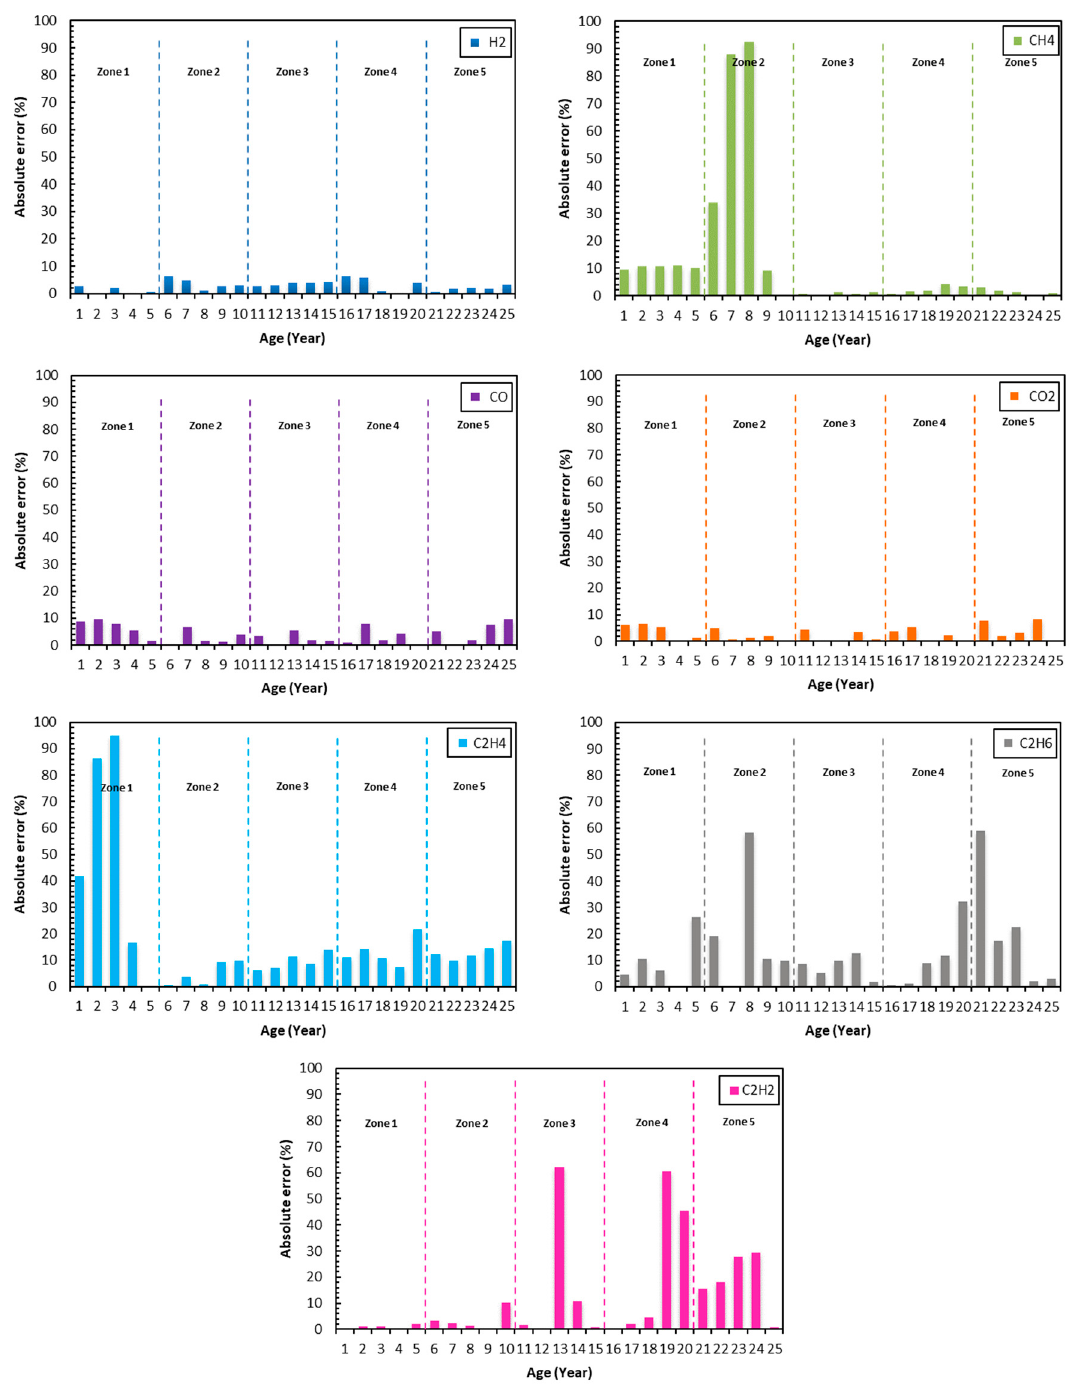
Figure 7. Percentage of absolute error between computed and predicted hydrogen, methane, acetylene, ethylene, ethane, carbon monoxide, carbon dioxide.